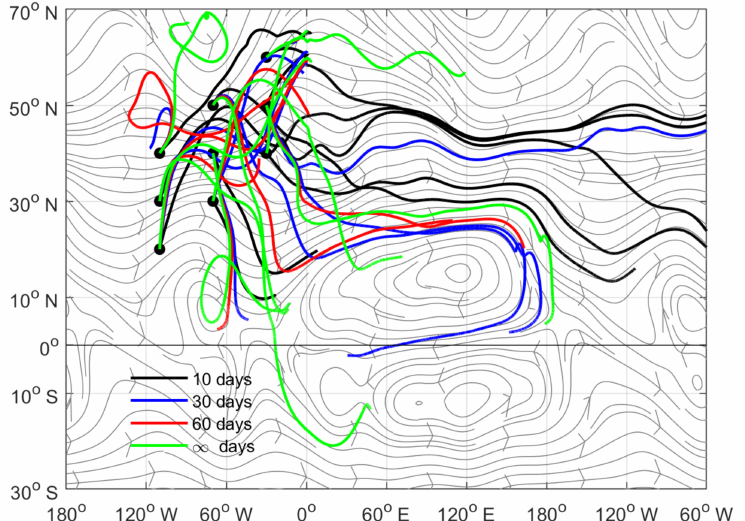
Figure 4. Ray paths of the 10 day (black), 30 day (blue), 60 day (red) and stationary waves (green) originated from the array of points (black solid points) in the western hemisphere. The point locations are 110 ◦ W, 20 ◦ N; 110 ◦ W, 30 ◦ N; 110 ◦ W, 40 ◦ N; 70 ◦ W, 30 ◦ N; 70 ◦ W, 40 ◦ N; 70 ◦ W, 50 ◦ N; 30 ◦ W, 40 ◦ N; 30 ◦ W, 50 ◦ N; 30 ◦ W, 60 ◦